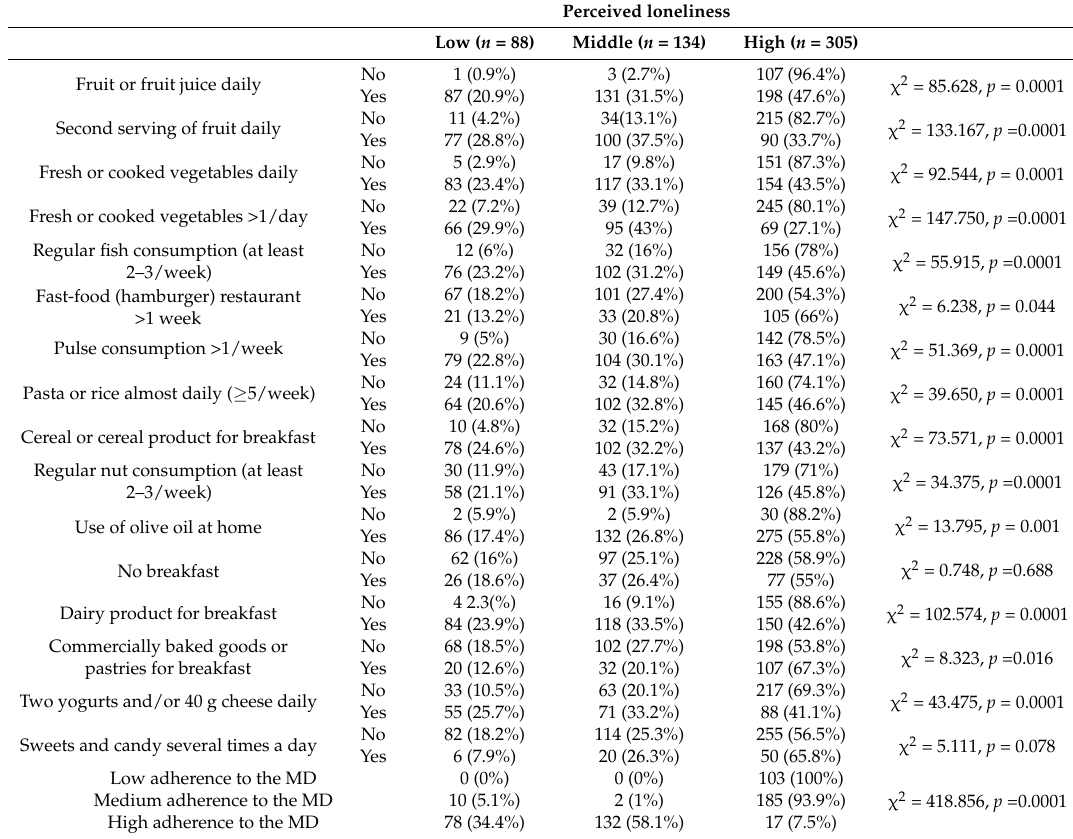
Table 3. Differences between groups on dietary patterns and adherence to the MD based on the frequency of feeling of